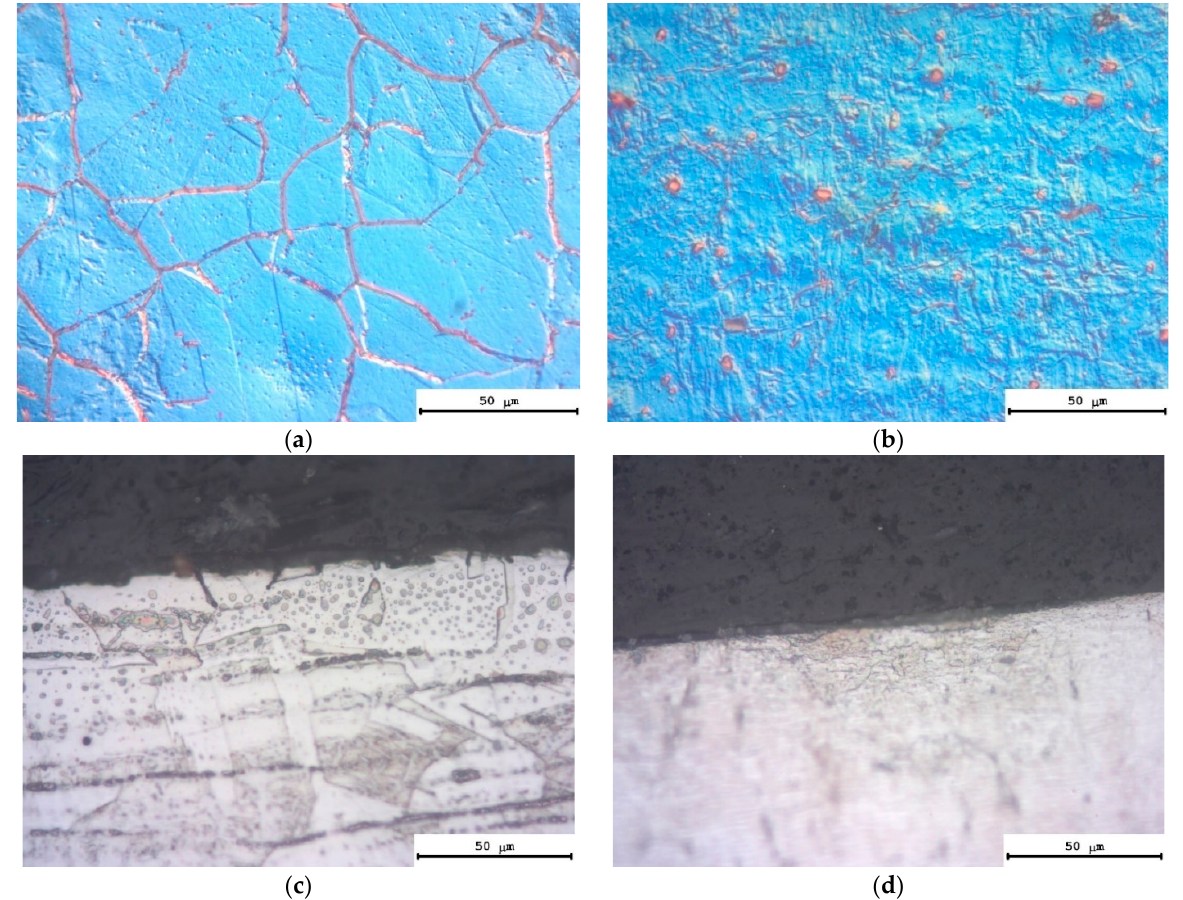
Figure 14. Surfaces of CG steel specimens ( a , c ) and UFG steel specimens (N = 4, 450 °C) ( b , d ) after DLEPR tests ( a , b ) and after tests in a boiling acid solution ( c , d ).